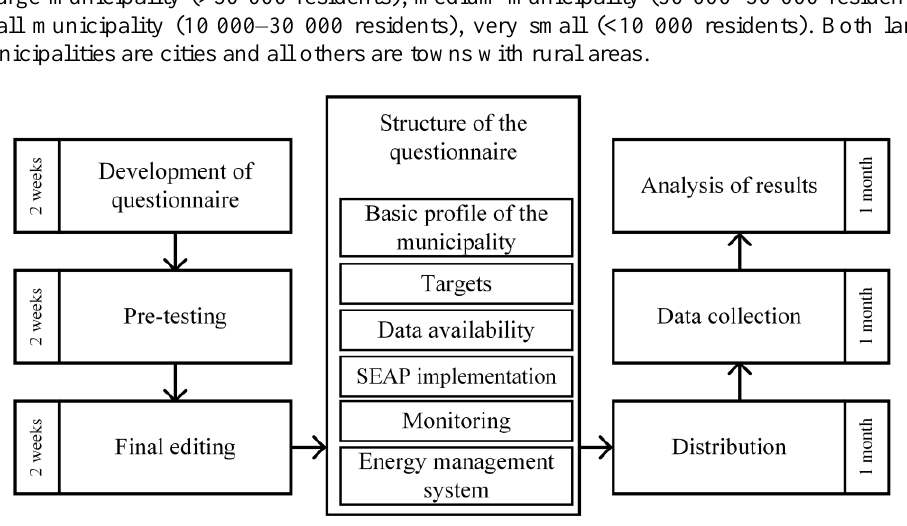
Fig. 1. Structure of the questionnaire